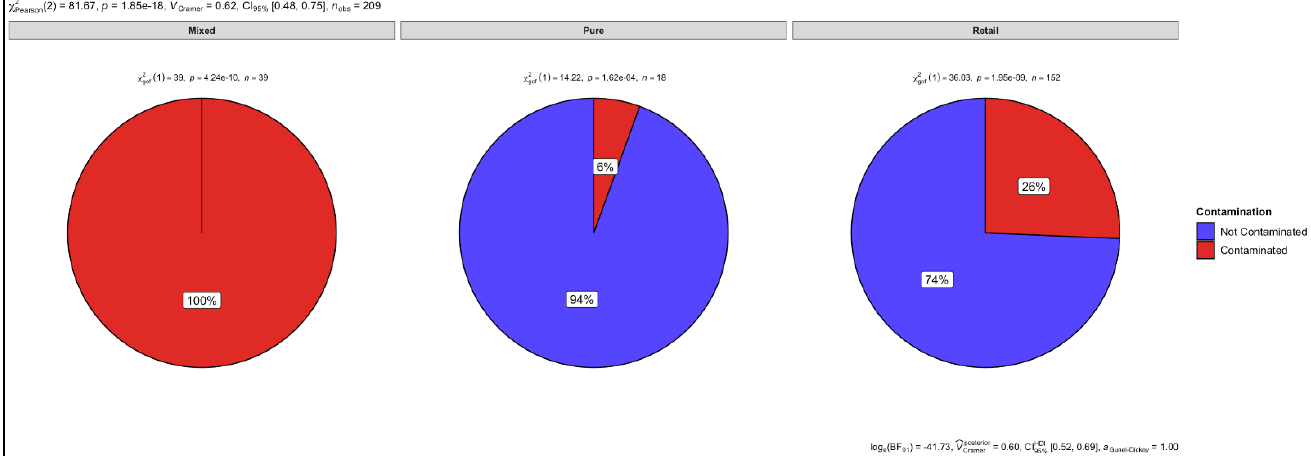
(Figure 13). The overall p value for all the retail samples was p = 1.02 × 10 − 5 . Cramer’s V association was 0.48, confidence interval (CI) was set at 95% (0.21, 0.55) and the number of samples observed (n obs ) were 152 (Figure